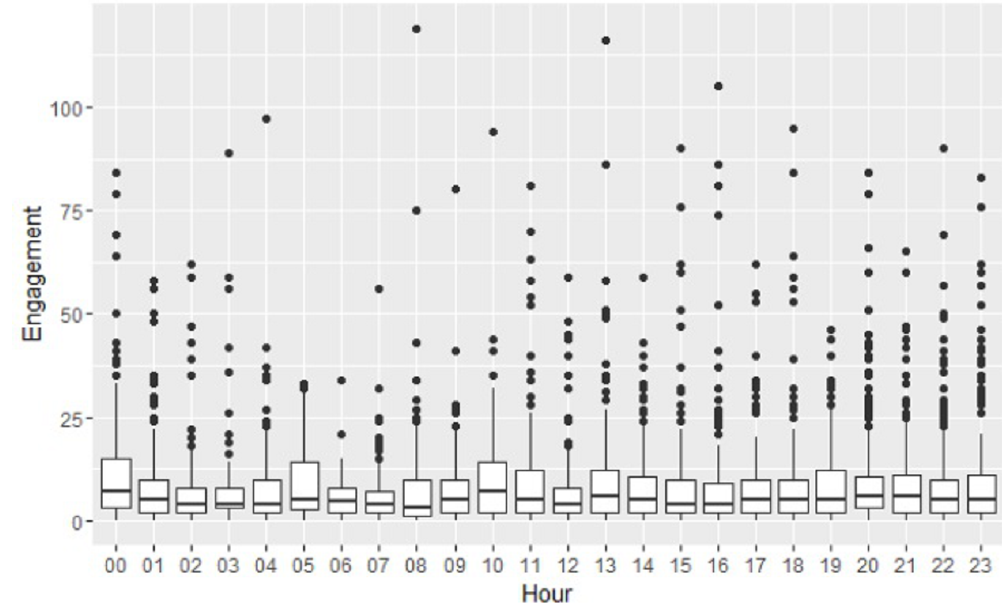
Figure 2. Engagement vs. hour.